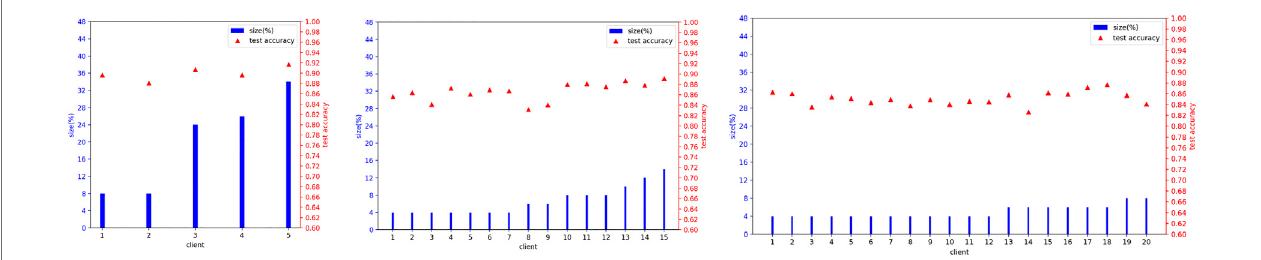
FIGURE 4 | Details of imbalanced distribution for local training set size and local model ’ s test accuracy at Epoch = 100 before aggregation.